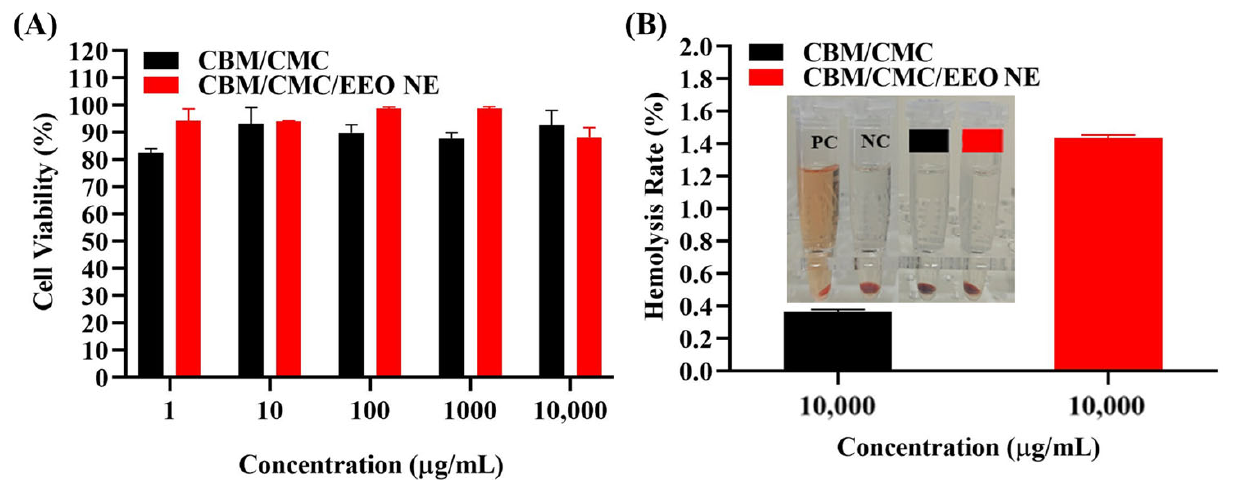
Figure Figure 4. In vitro biocompatibility. ( A ) Cytotoxicity analysis of different concentrations (1–10,000 μ g/mL) of CBM/CMC and CBM/CMC/EEO NE hydrogel extracts on mouse fibroblasts L929. ( B ) 10,000 μ g/mL CBM/CMC and CBM/CMC/EEO NE hydrogel extracts for hemolysis of chicken blood erythrocytes.